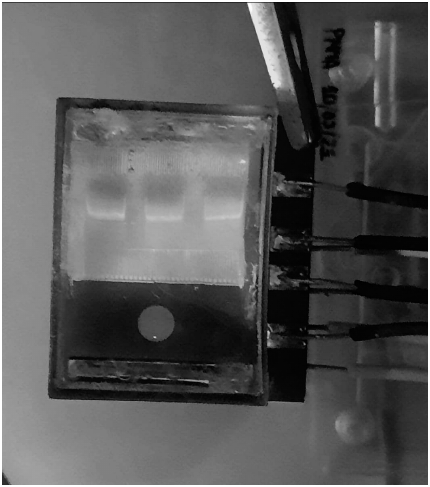
Figure 9. Bands obtained after migrating the DNA by